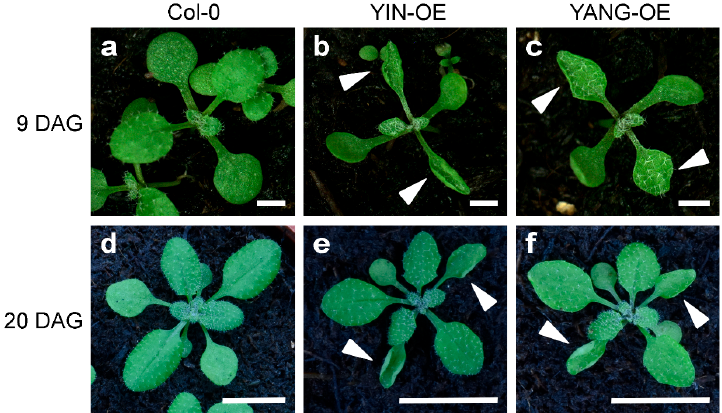
Figure 5. Vegetative phenotype of Arabidopsis YIN_OE and YANG_OE lines (T4 generation). The plants grew on soil for nine days ( a – c ; scale bars = 100 mm) or twenty days ( d – f ; scale bars = 1 cm), respectively. The overexpression of YIN and YANG caused up-curling of the primary leaves (arrow- heads). Note that the leaf curling phenotype affected mainly juvenile leaves and was homogeneous mild in the T3 and T4 generation of all 10 transgenic lines (5 YIN_OE and 5 YANG_OE lines) which were used for all analyses in this study. However, some plants of the T1 generation showed stronger curling in almost all leaves (Supplementary Figure